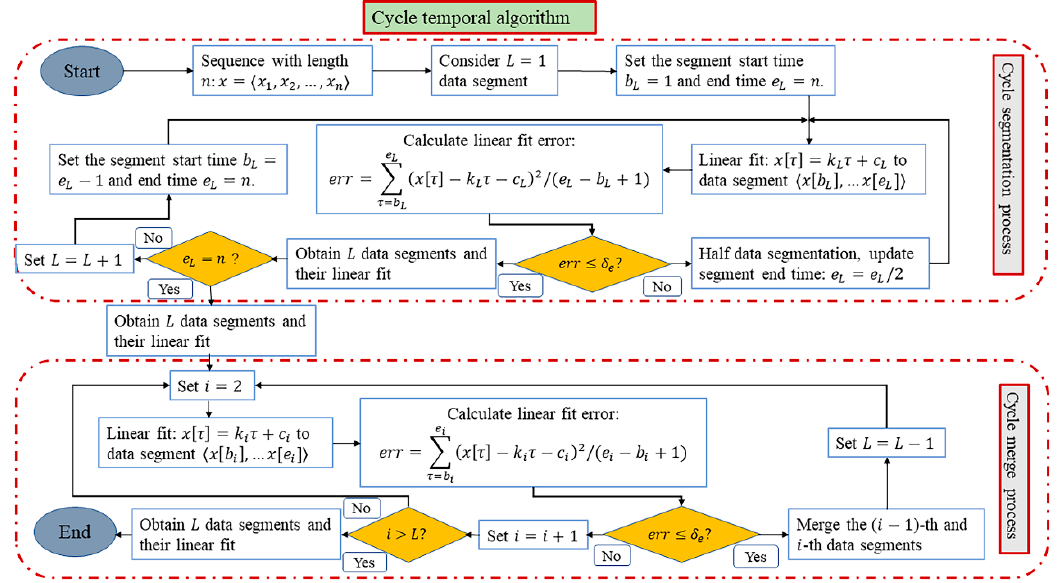
Figure 1. Cycle temporal algorithm (CTA) process.